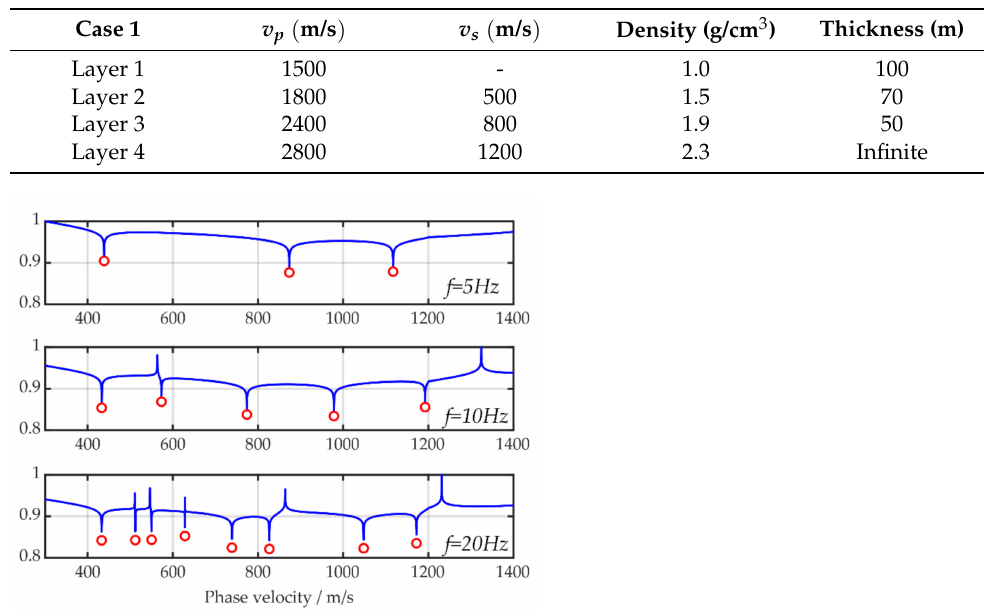
Figure 3. Normalized dispersion function of the Stiffness matrix method of model 1 at the frequencies of 5, 10, and 20 Hz, along with its roots (illustrated by circles).